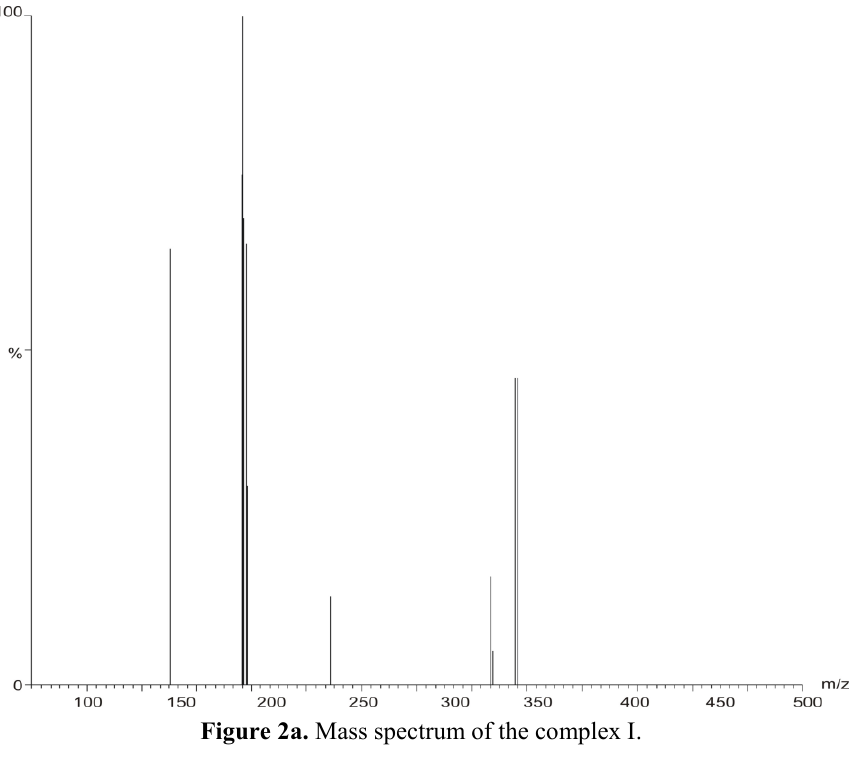
Figure 2a. Mass spectrum of the complex I.